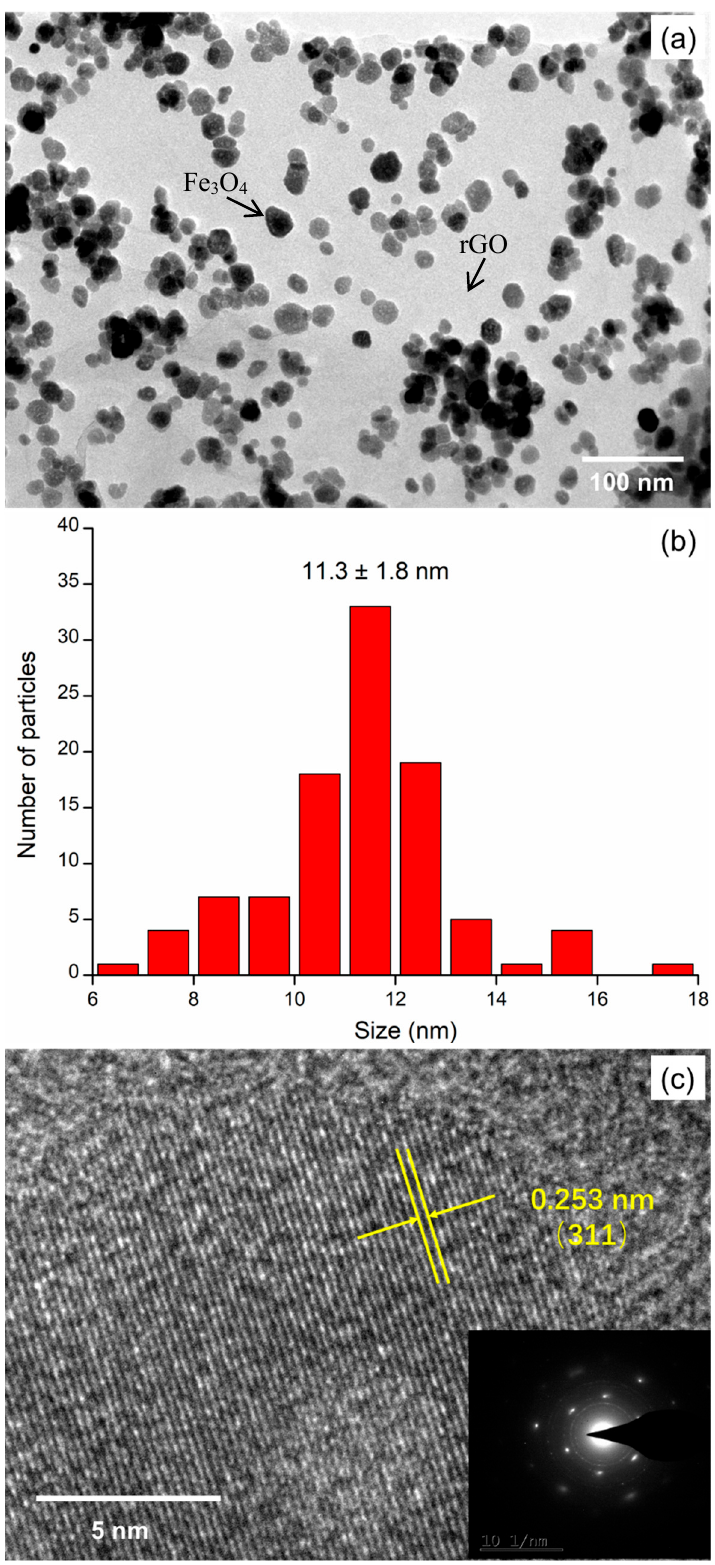
Figure 5. ( a ) Transmission electron microscope image of rGO-Fe 3 O 4 , ( b ) particle size histograms of Fe 3 O 4 particles, ( c ) high-resolution transmission electron microscopy image of rGO–Fe 3 O 4 , inset shows the selected area electron diffraction pattern.